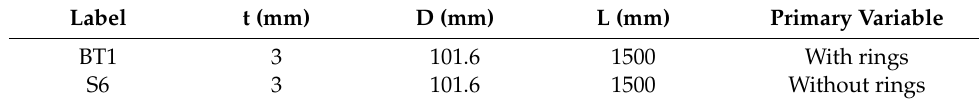
Table 5. The second group of specimens of parametric case studies.